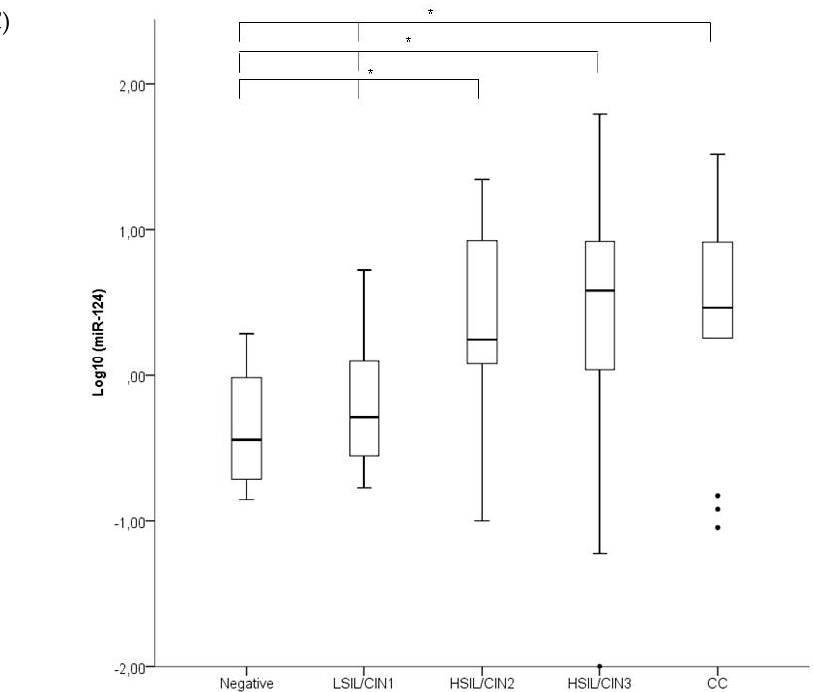
Figure 1. Boxplots of the levels of CADM1 ( A ), MAL ( B ), and miR124 ( C ) expressed as 10log-transformed values, in women with normal, low-grade squamous intraepithelial lesion/cervical intraepithelial neoplasia grade 1 (LSIL/CIN1), high-grade squamous intraepithelial lesion/cervical intraepithelial neoplasia grades 2 (HSIL/CIN2), HSIL/CIN3, and cervical cancer (CC). The black line within the box represents the median; the whiskers represent the minimum and maximum values that lie within 1.5 interquartile ranges from the end of the box. Values outside this range are represented by black dots. * CADM1 showed lower levels of methylation in LSIL/CIN1 samples compared with HSIL/CIN3 and CC ( p = 0.006 and p = 0.031, respectively) and lower levels of methylation in HSIL/CIN2 samples compared with HSIL/CIN3 and CC ( p = 0.008 and p = 0.008, respectively). Methylation levels of the MAL promoter gene were lower in negative and LSIL/CIN1 samples compared with HSIL/CIN3 ( p = 0.001 and p = 0.003, respectively) and CC ( p = 0.003 and p = 0.003, respectively). MAL also showed lower methylation levels in HSIL/CIN2 samples compared with CC ( p = 0.029). miR124 showed lower levels of expression in negative and LSIL/CIN1 samples compared with HSIL/CIN2 ( p = 0.001 and p = 0.003, respectively), HSIL/CIN3 ( p < 0.001 and p < 0.001, respectively) or CC ( p = 0.019 and p = 0.024, respectively).